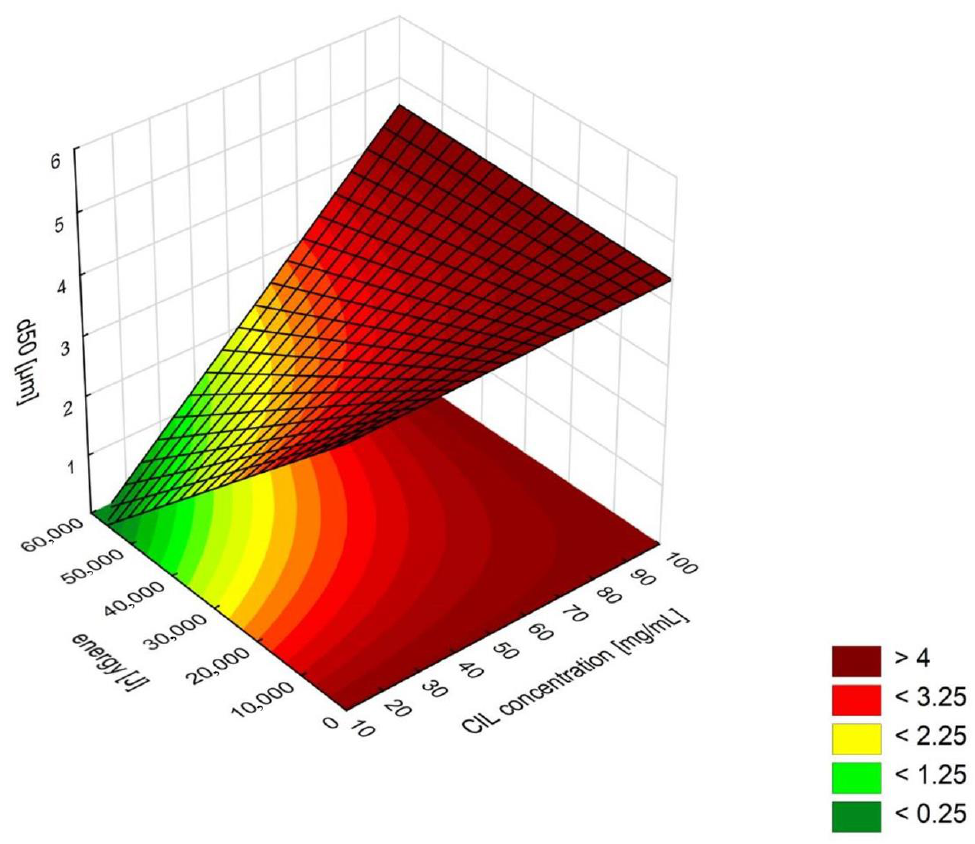
Figure 7. Response surface map for precipitation-sonication process with d50 value as